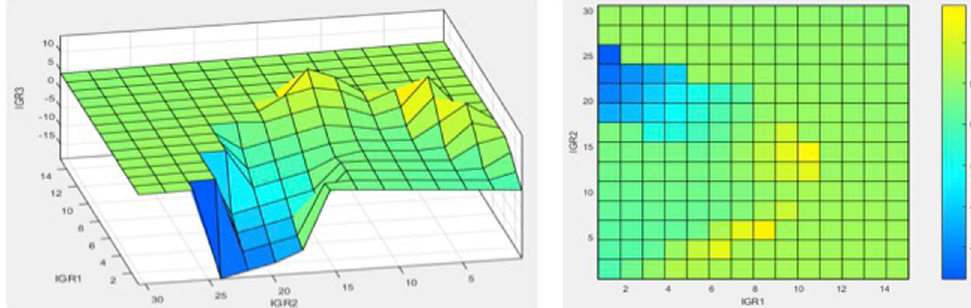
Figure 4. Final decision surface built by covering all the implications of the input data space. ( a ) 3D surface view, and ( b ) View from top [contour view]. X-axis represents IGR1 input; Y-axis IGR2 input while the output IGR3 is shown on the z-axis based on the above